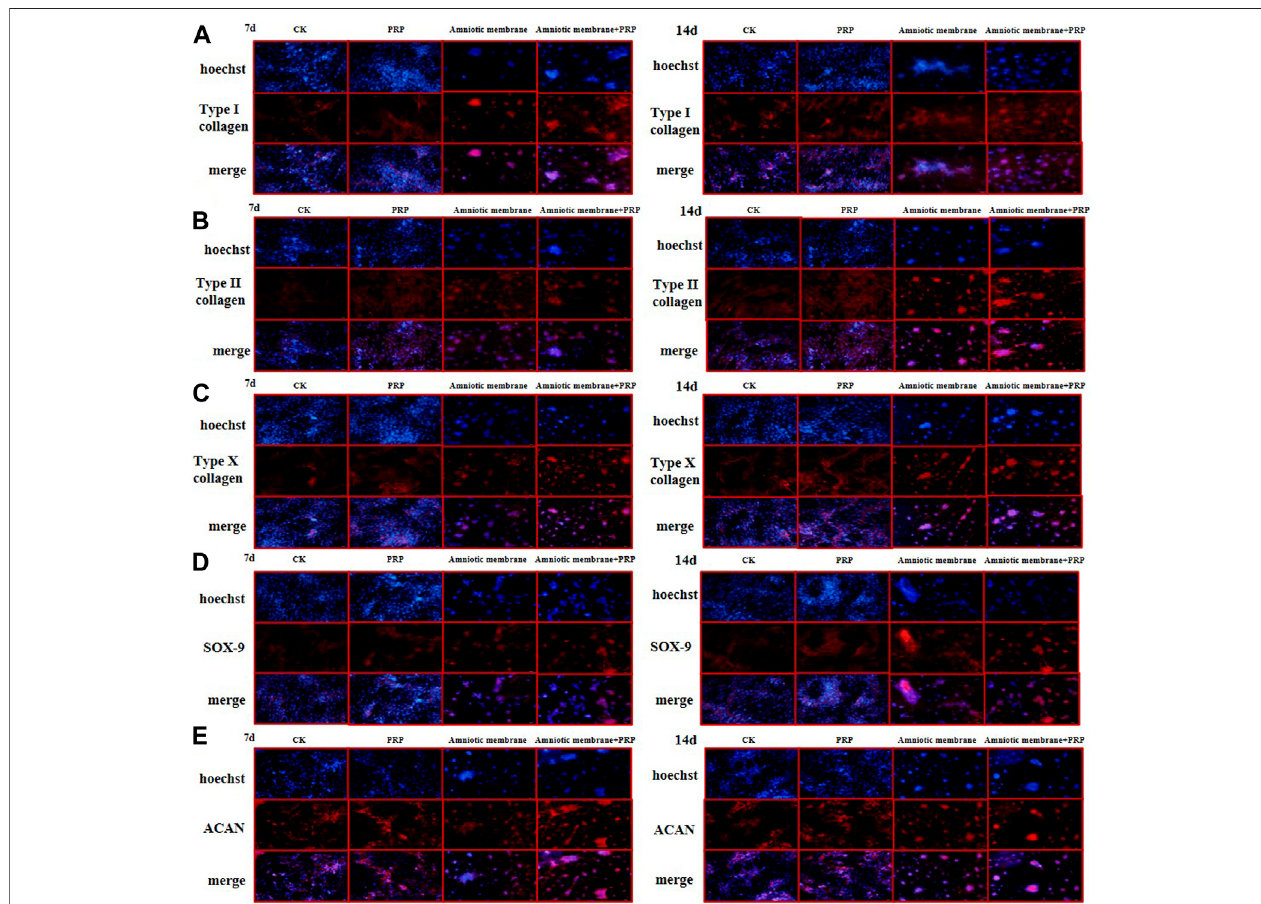
FIGURE 5 | The protein expression levels of collagen I/II/X, Sox-9, and ACAN genes were the highest in ADSCs treated with amniotic membrane plus PRP scaffolds. The in vitro culture experiment of ADSCs was divided into four groups, including CK: ADSC alone; PRP: PRP + ADSC; amniotic membrane: amniotic membrane+ADSC;PRP+amniotic membrane: ADSC+PRP+ amniotic membrane. Immuno fl uorescencetests were performed after 7and 14 days co-culture. (A – E) The expression level of type (A) I collagen, (B) type II collagen, (C) type X collagen. (D) SOX-9, and, (E) ACAN in ADSCs cultured with amniotic membrane + PRP scaffoldsonday7andday14wassigni fi cantlyhigherthanthatinothergroups,andtheexpressionlevelonday14wassigni fi cantlyhigherthanthatonday7.Theprotein expression of each gene is amniotic membrane + PRP scaffolds group > amniotic membrane scaffolds group > PRP scaffolds group > CK group, n (cid:2) 3.